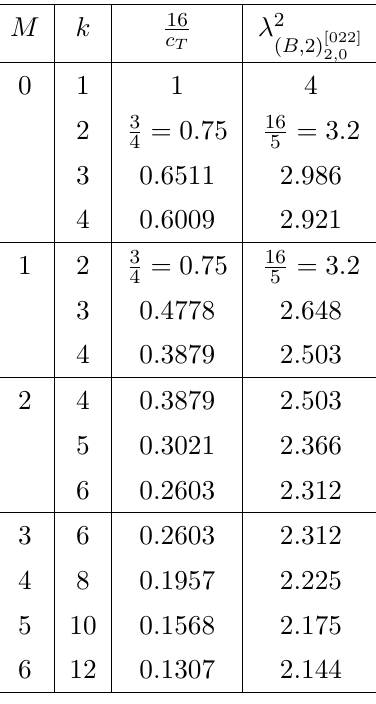
and λ 2 in various SO(2) 2 k × USp(2 + 2 M ) − k c T ( B, 2) [022] 2 , 0